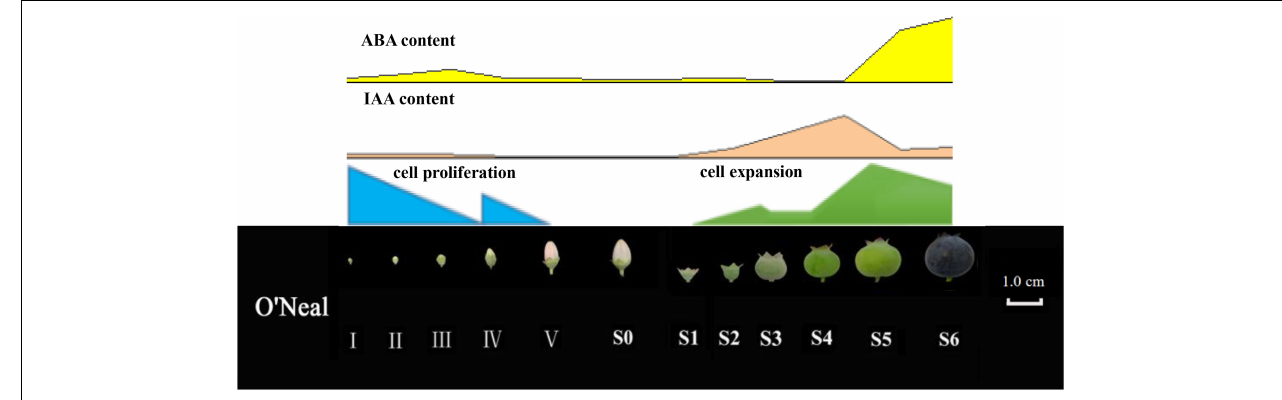
FIGURE 6 | Morphological, cytological and phytohormonal changes of V. corymbosum ‘O’Neal’ throughout